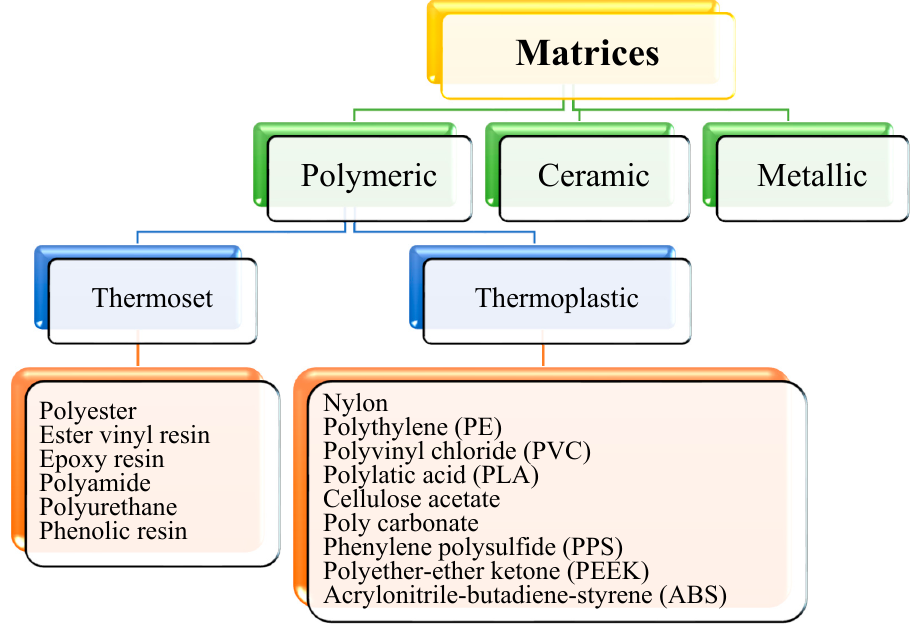
Figure 5. Various types of polymeric matrices.